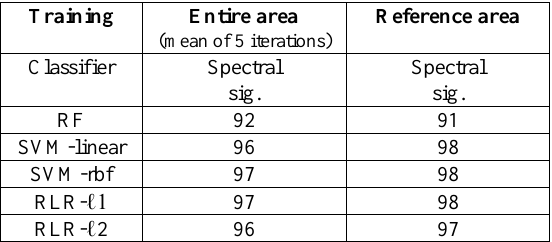
Table 4 . Mean overall accuracies obtained during cross-